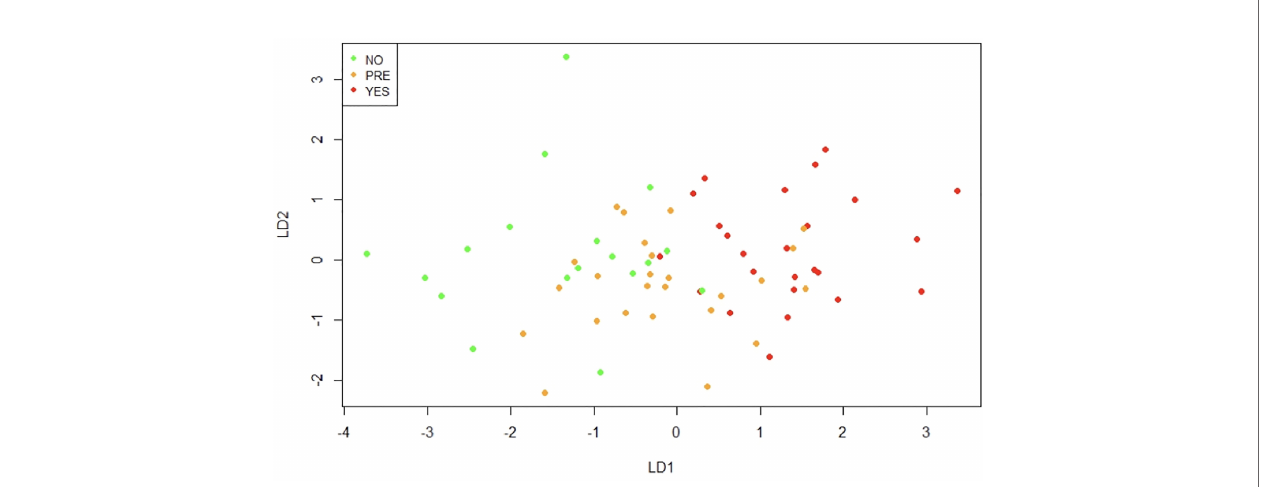
FIGURE 9 | Linear discriminant analysis (LDA). This method identi fi es the linear combinations of variables that better separate the observations. NO (non-type 2 diabetes group), PRE (pre-type 2 diabetes group), YES (type 2 diabetes group), LD1 (linear discriminant 1), LD2 (linear discriminant 2),